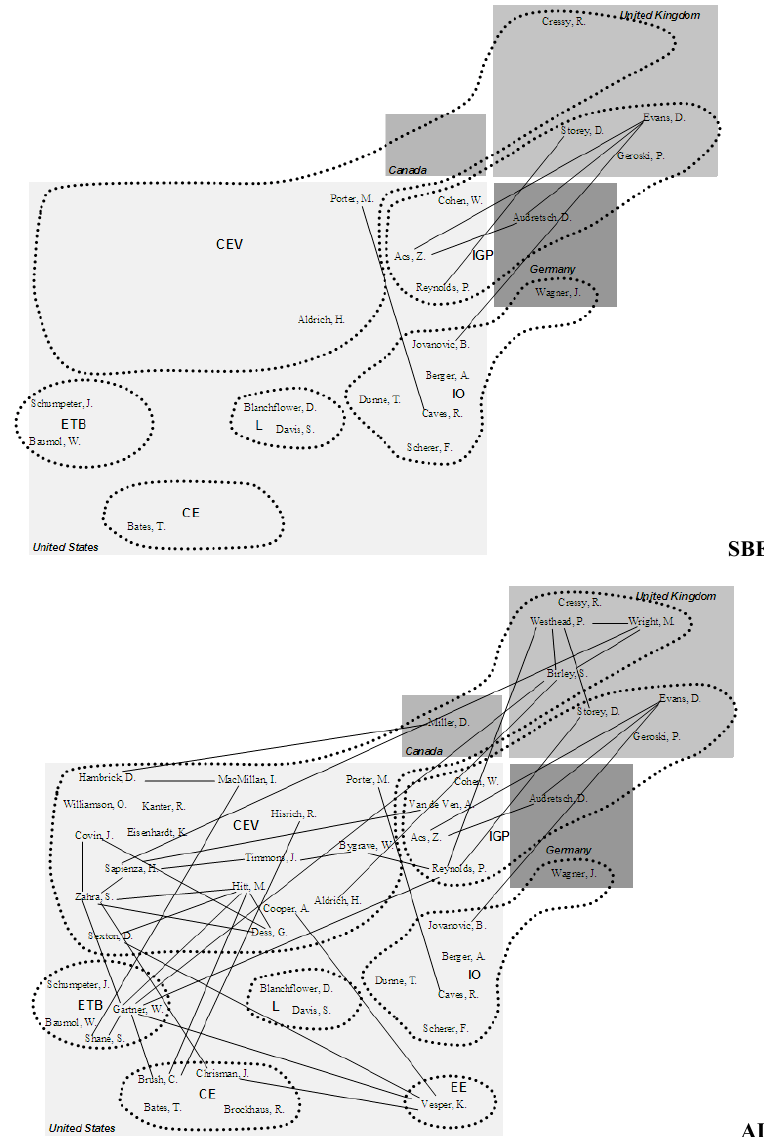
Fig.1. Mapping the international scientific linkages of the most influential authors in entrepreneurship by ‘core